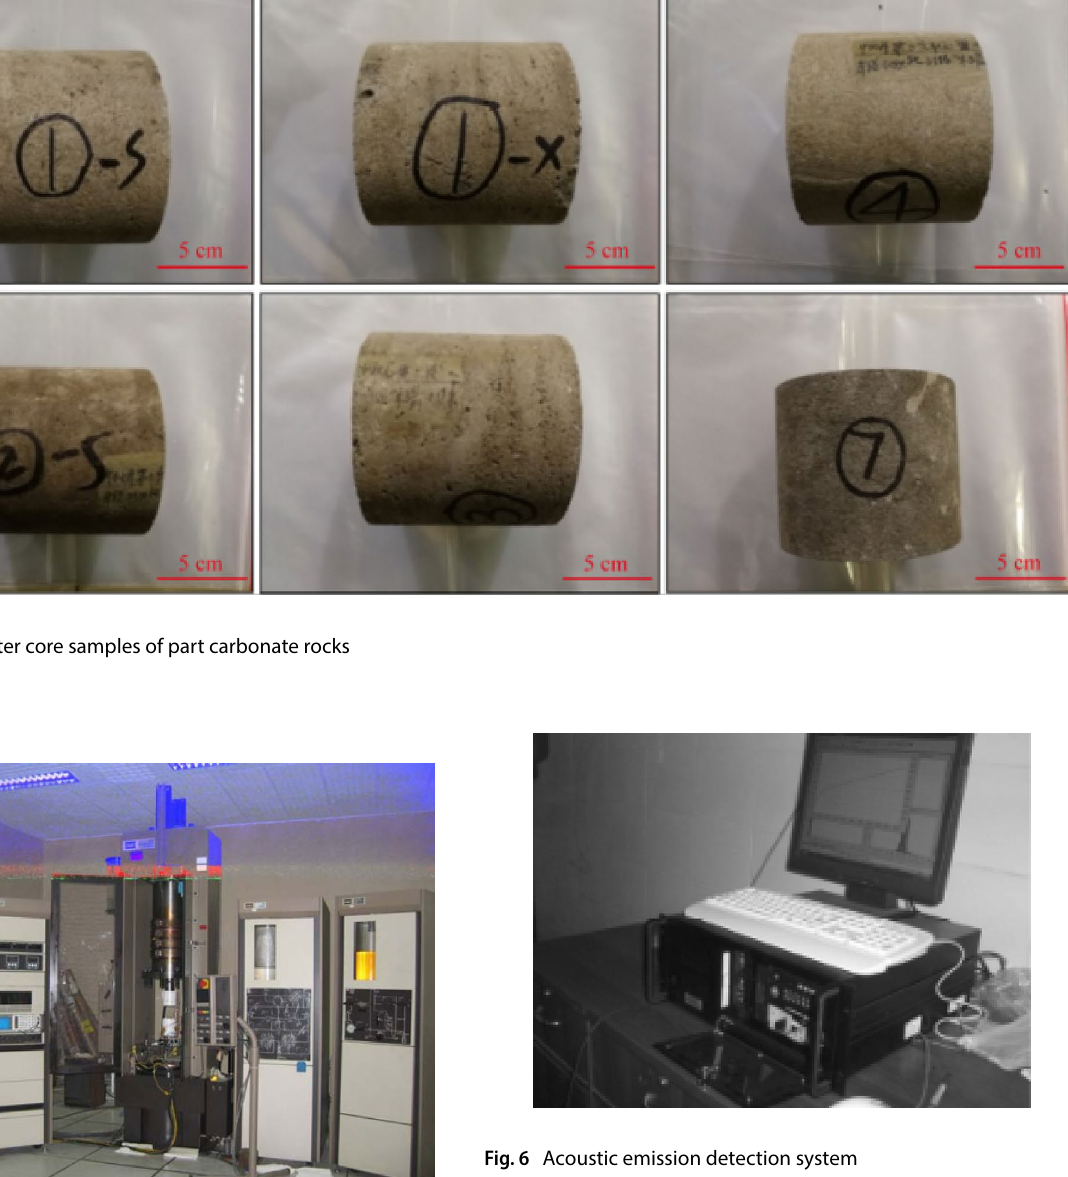
Fig. 5 Rock testing system